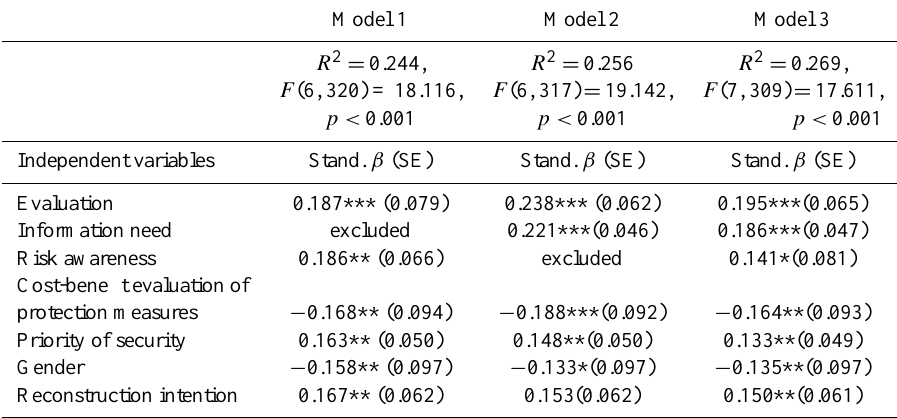
Table 3. Predictors of preparedness (future intention).